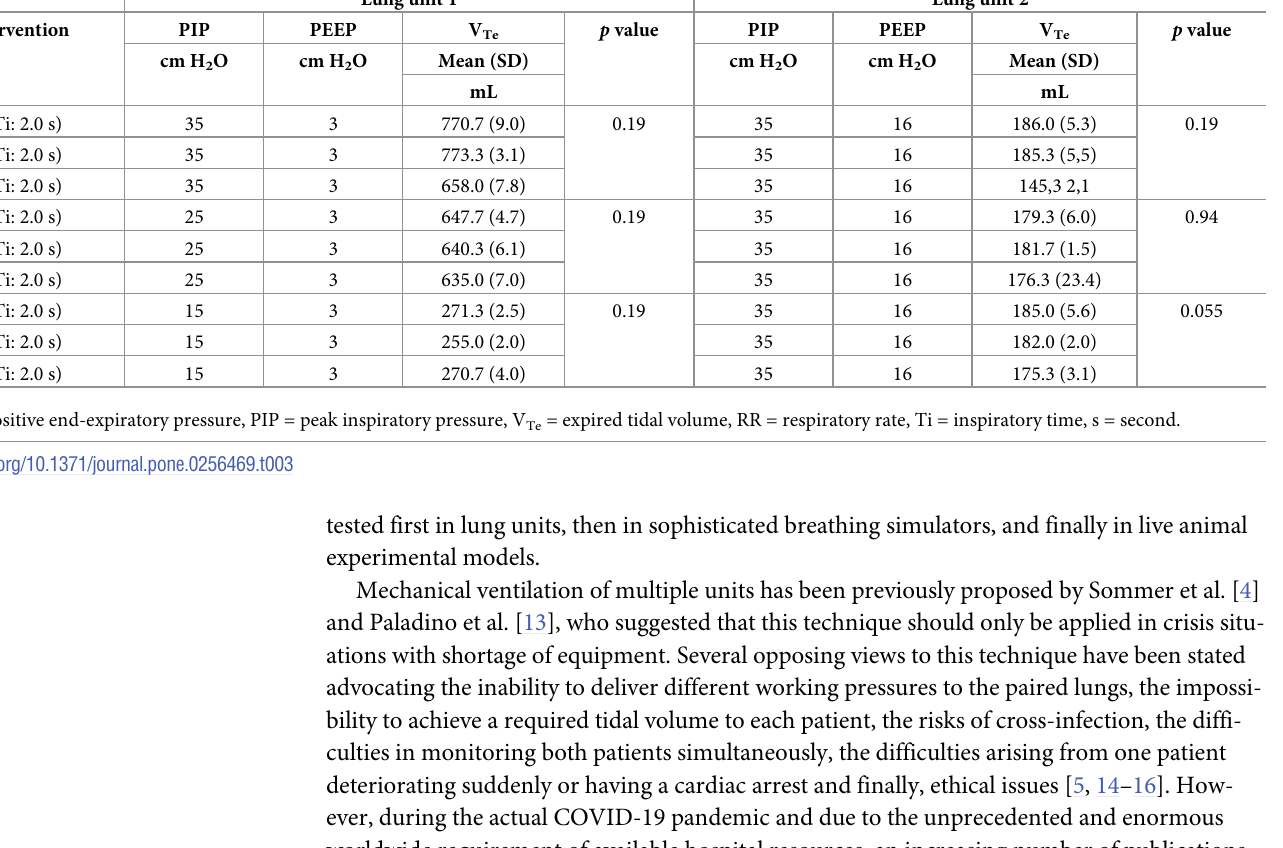
Table 3. Resulting variations of VT e (mL) in paired lung units after a sole modification of the respiratory rate in the ventilator using a fixed inspiratory time of 2 seconds, while applying a flow restriction of 0, 10 and 20 cm H 2 O in lung unit 1, which resulted in a PIP of 35, 25 and 15 cm H 2 O, respectively. Lung unit 1 Lung unit 2 Intervention PIP